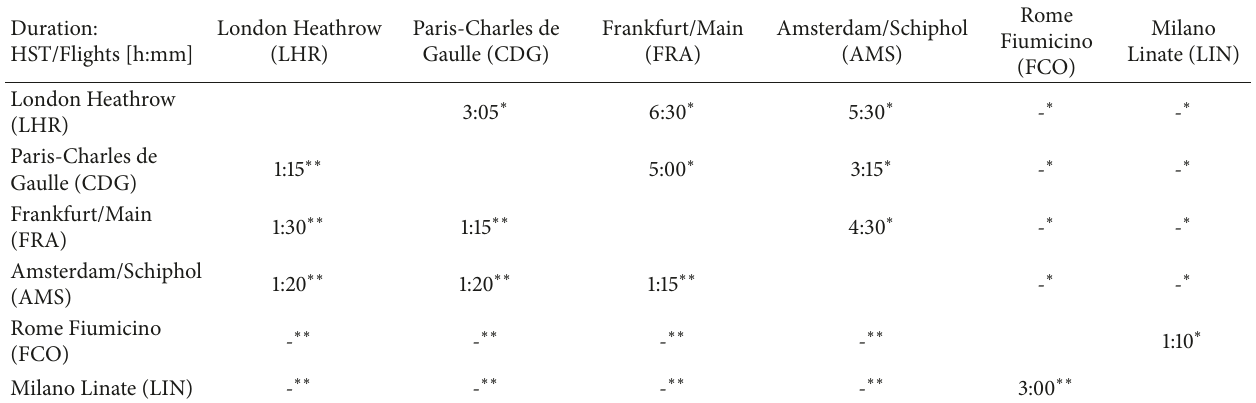
Table 3: Relative journey duration for railways ( ∗ ) and air flights ( ∗∗